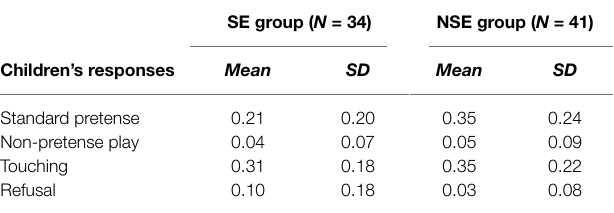
TABLE 1 | Children’s mean proportion of each behavioral category during the scale error task period, except for the time exhibiting scale error behavior. SE group ( N = 34)